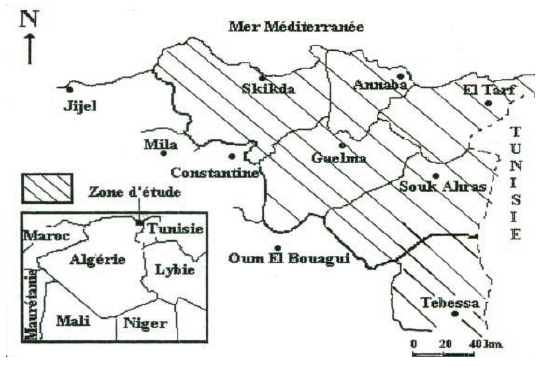
Fig. 1 Geographic